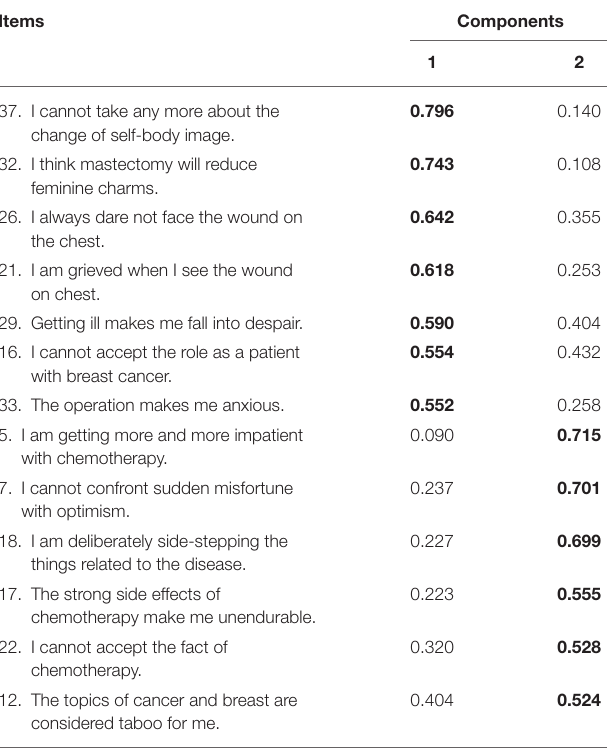
TABLE 2 | Exploratory factor analysis of 13 common